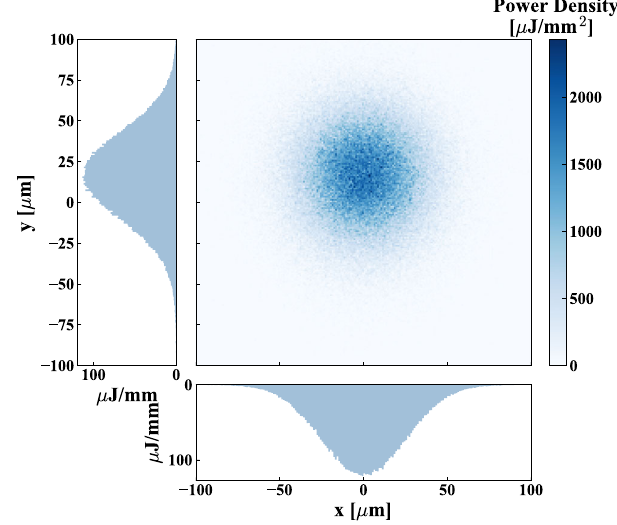
FIG. 5. The density of absorbed energy over the transverse plane. The corresponding marginal distribution is also shown. The maximum energy density reaches 2400 μ J = mm 2